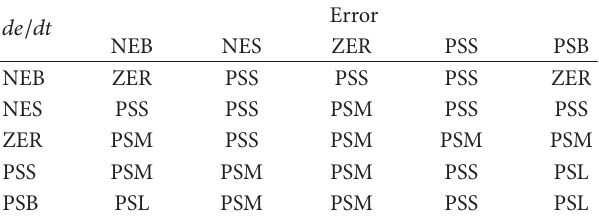
Table 4: If-then rule of fuzzy logic controller for 𝐾 𝑇